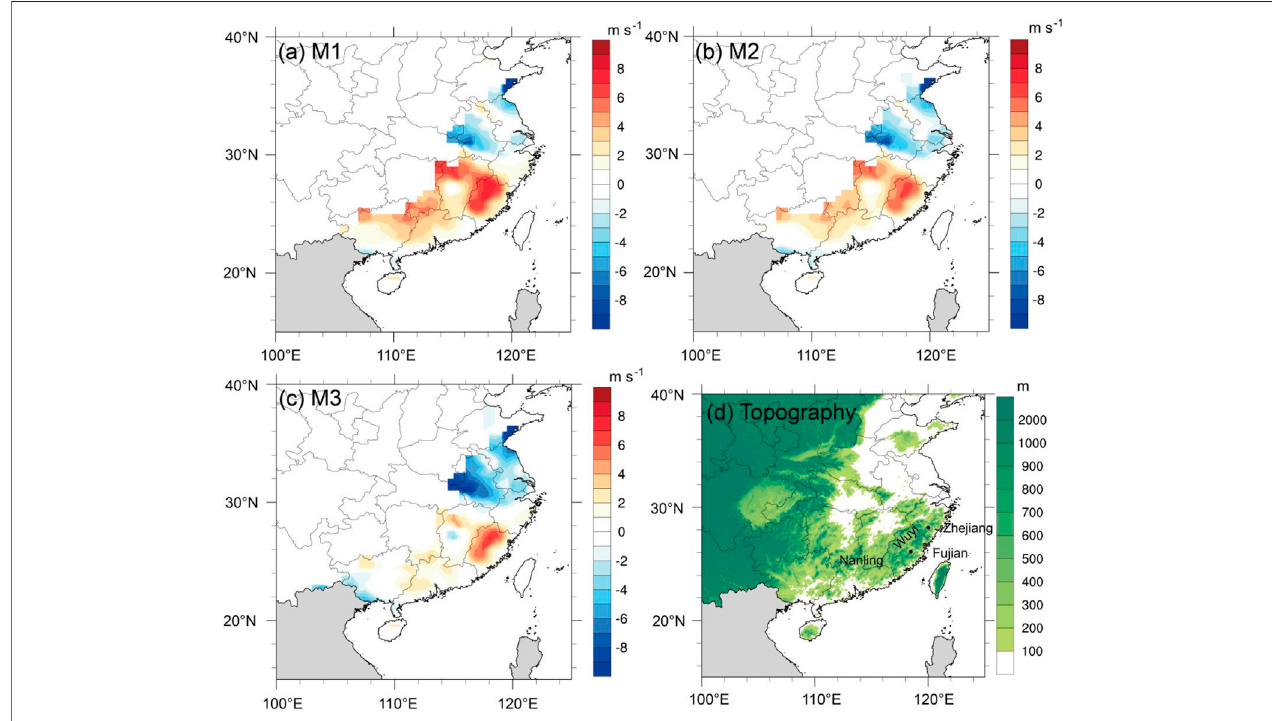
FIGURE 5 | The spatial distribution of biases (m s − 1 ) in (A) M1, (B) M2, and (C) M3 for TCs making landfall over China during 1980 – 2018. (D) Topographic map of China.